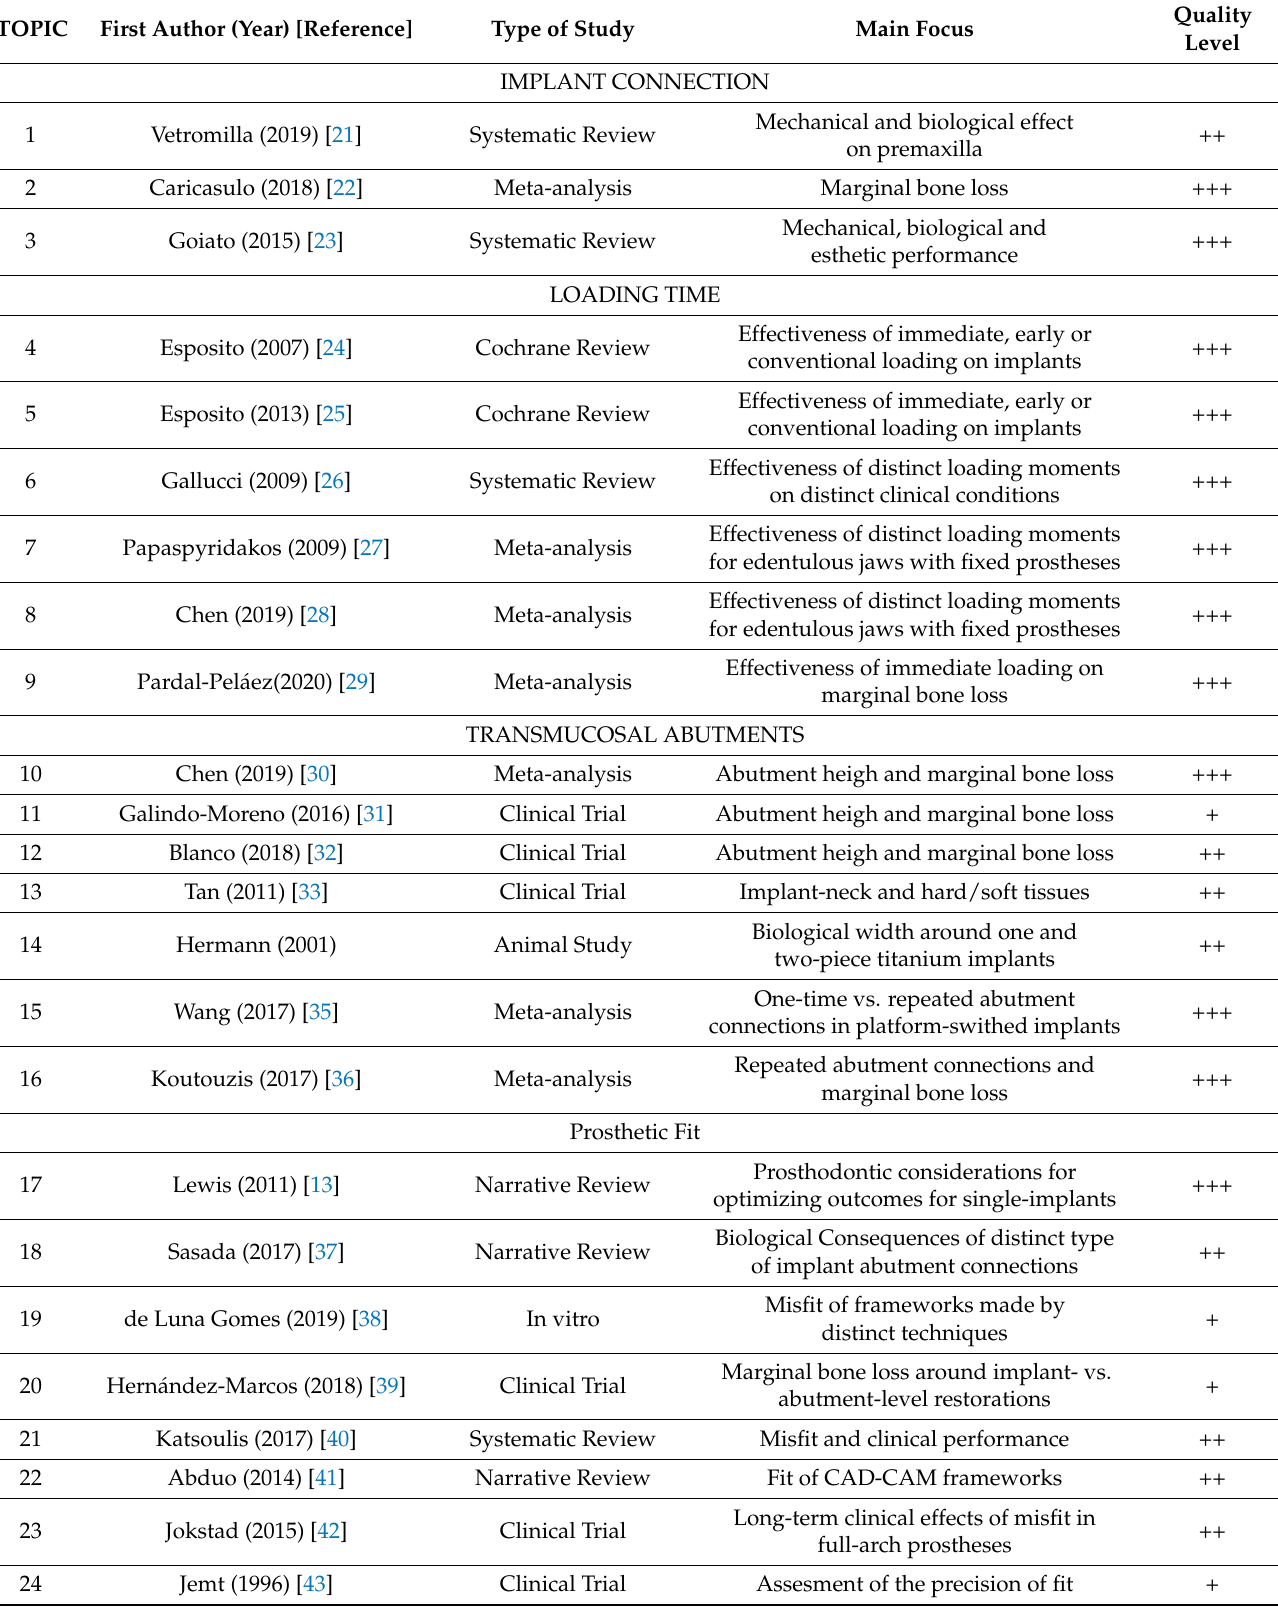
Table 1. Summary and brief description of the included studies supporting each pronostic